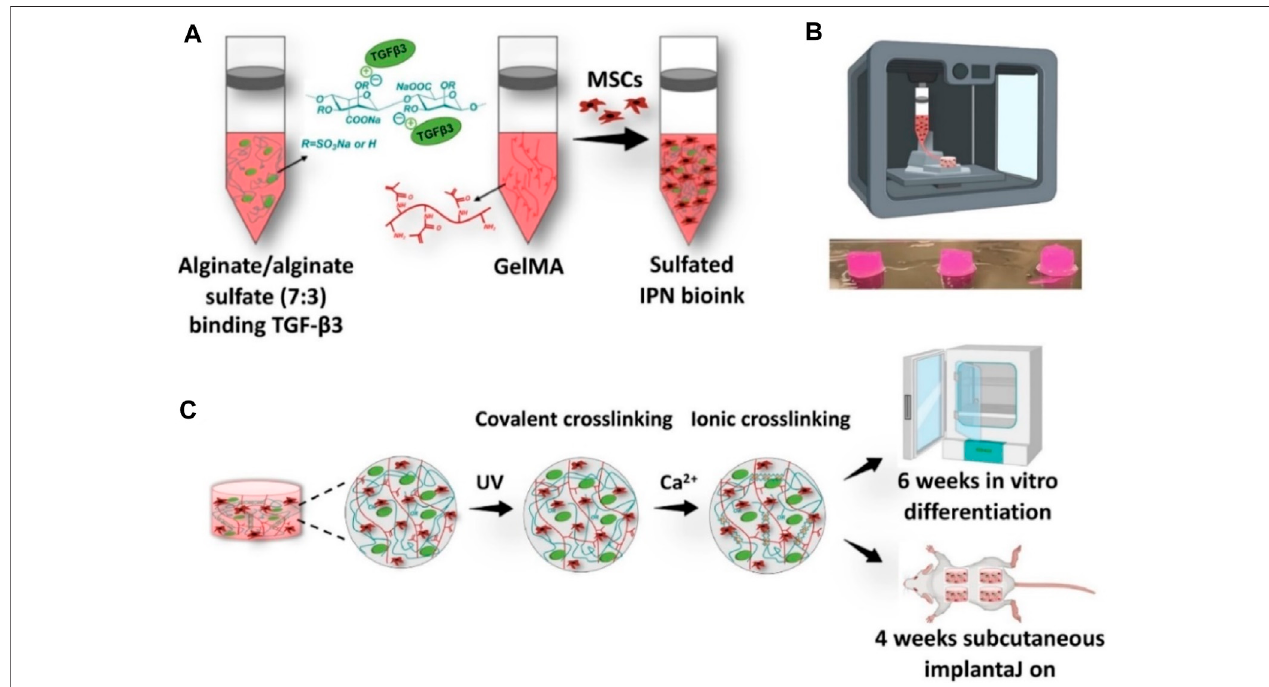
FIGURE 5 | Schematic representation of alginate/alginate sulfate-GelMA IPN bio-ink and bioprinting constructs using the ionic cross-linking strategy. (A) Preparation of bio-ink. (B) Image of 3D-bioprinting constructs. (C) Cross-linking processes. Reproduced from Wang et al., (2021) with permission from Copyright 2021 Elsevier.